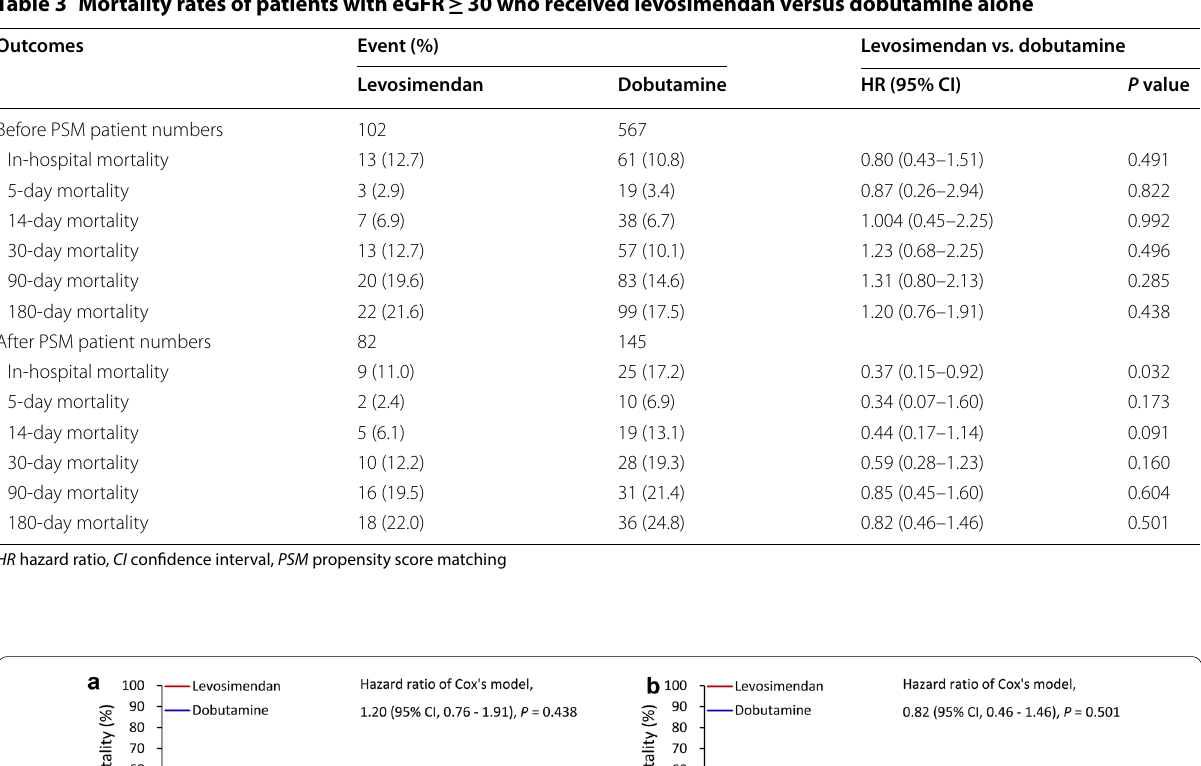
Table 3 Mortality rates of patients with eGFR